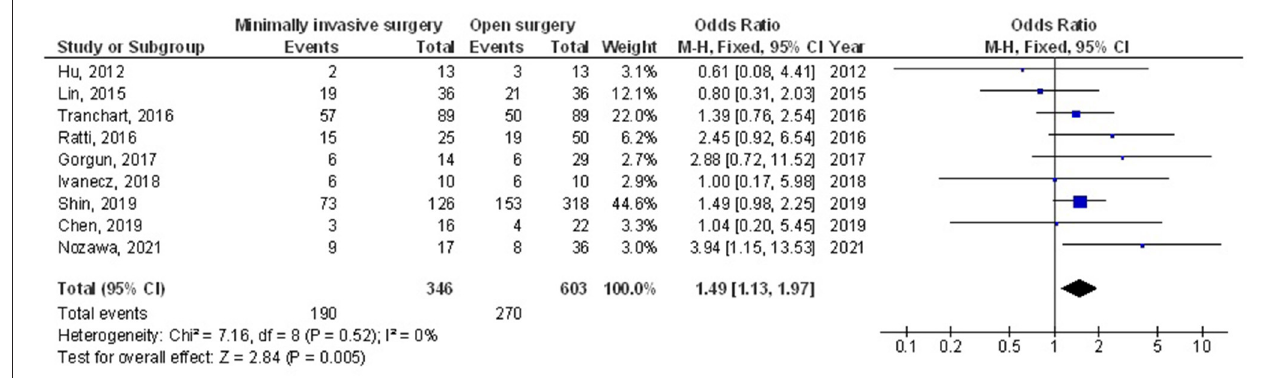
FIGURE 2 | Forest plot of the effect of minimally invasive surgery compared to open surgery on operation time in subjects with colorectal cancer and synchronous colorectal liver metastases.